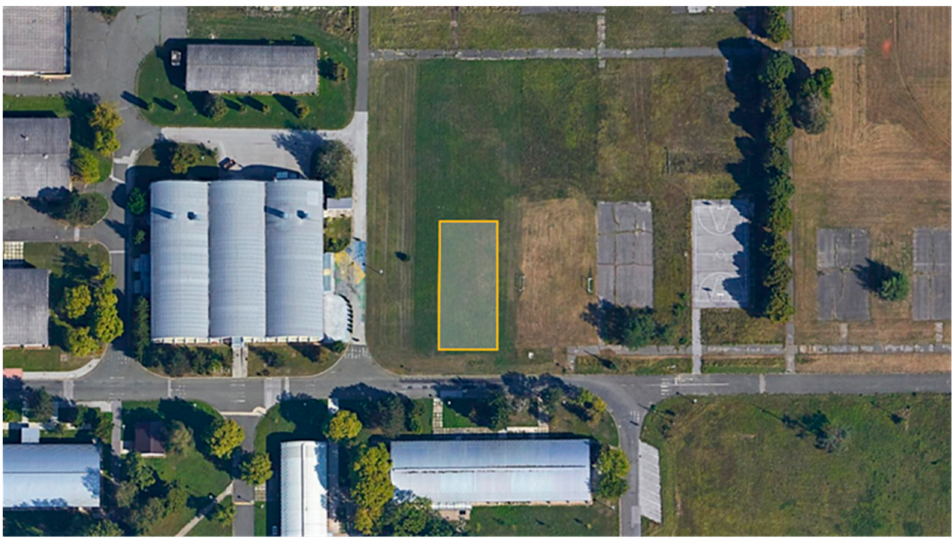
Figure 1. The measurement polygon.